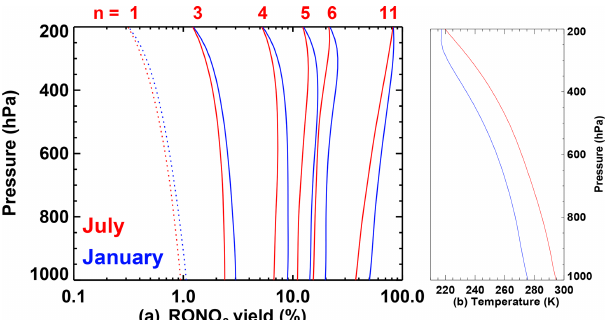
Figure 2. (a) Organic nitrate yield in the reaction of peroxy radicals with NO calculated following Wennberg et al. (2018) as a function of atmospheric pressure, using temperature profiles typical of Jan- uary (in blue) and July (in red) at 40 ◦ N (zonal average of ECMWF analyses). The temperature profiles are shown in panel (b) . n is the number of heavy atoms in the peroxy radical. For n = 1, the yield is calculated with Z = 1 in Eq.